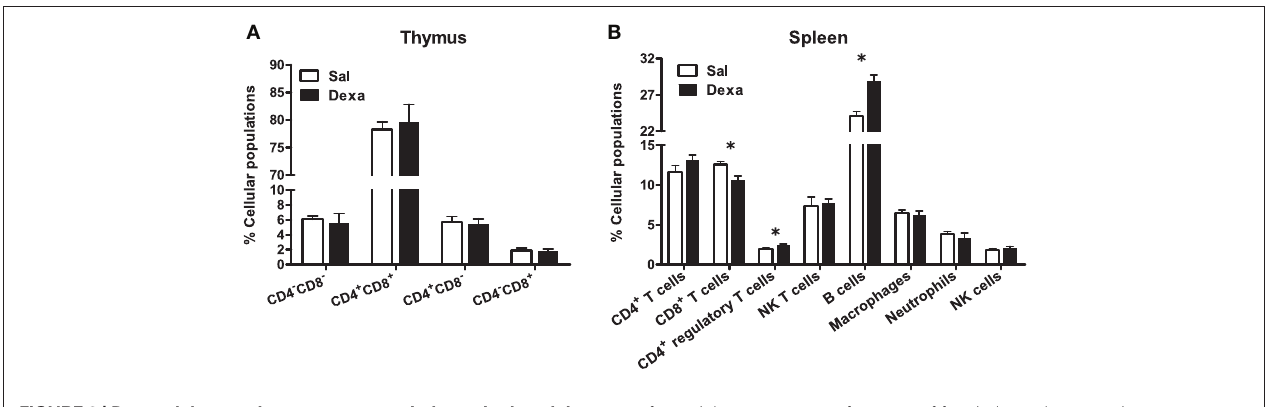
FIgure 3 | Prenatal dexamethasone treatment induces, in the adult progeny, alterations in splenic CD8 + and CD4 + regulatory T and on B cells but not in the proportion of the four main thymic cell populations. (A) Thymocytes from Sal and Dexa groups were stained with specific antibodies and analyzed by flow cytometry. Data are represented as the mean + SEM,